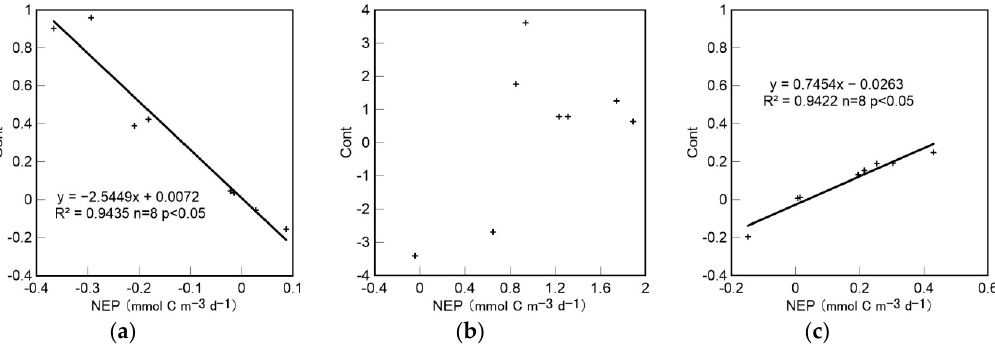
Figure 8. Correlations between Cont and NEP in the near-shore ( a ), front ( b ), and offshore ( c ) regions in the mixed layer in summer. in the mixed layer in